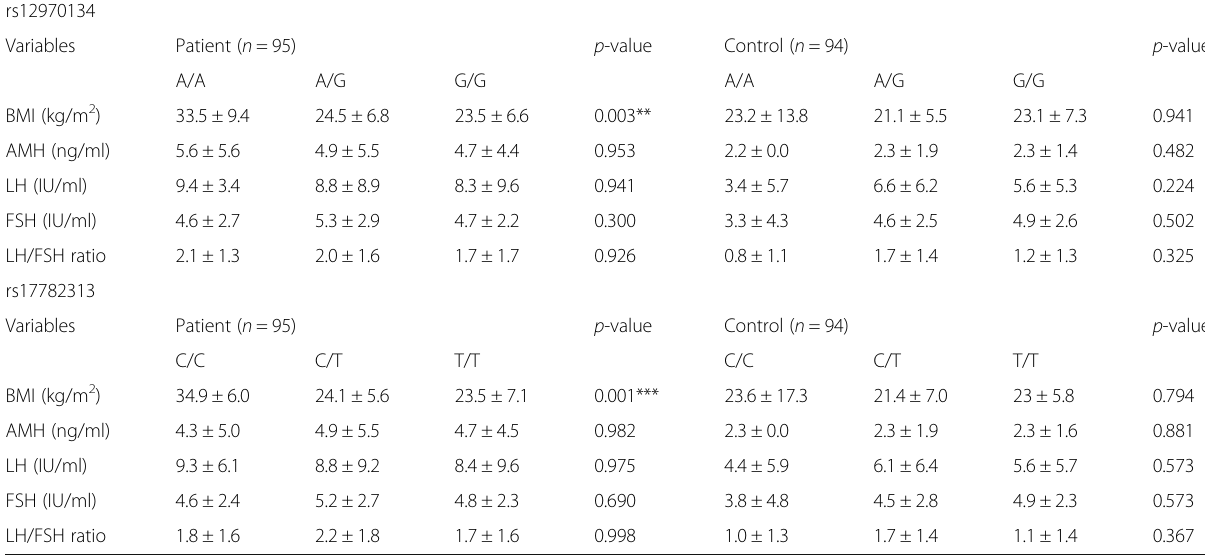
Table 3 Association between MC4R variants rs12970134 and rs17782313 and the multiple variables